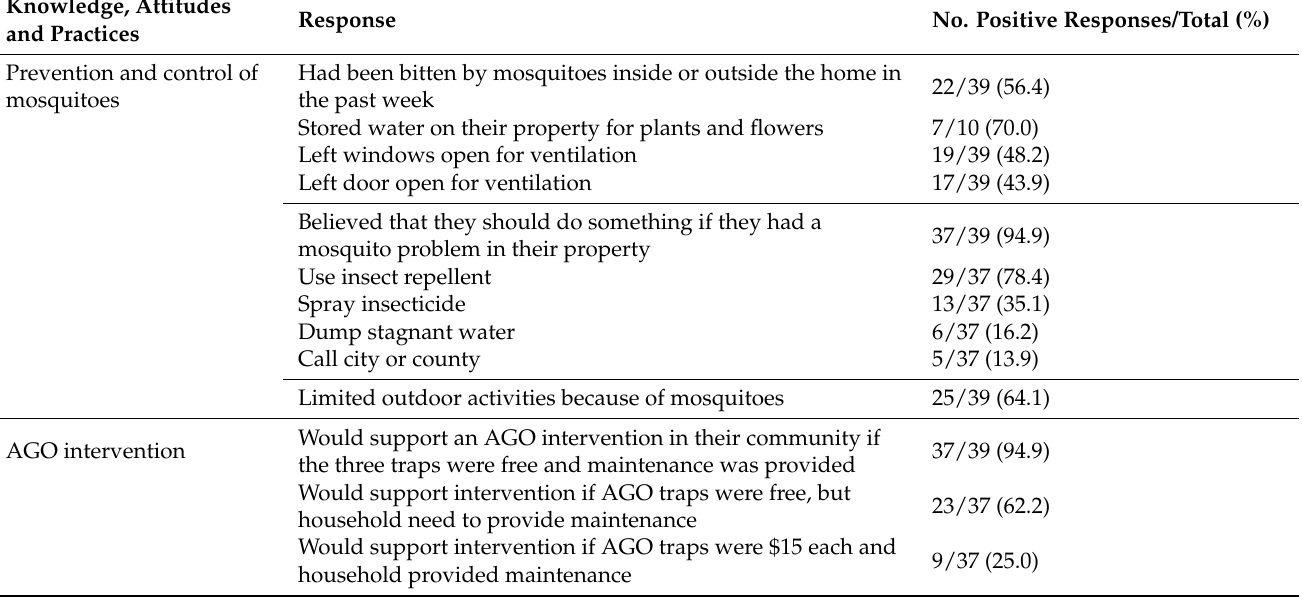
Table 4. Knowledge, attitudes, and practices of household owners in the Lower Rio Grande Valley, related to prevention and control of